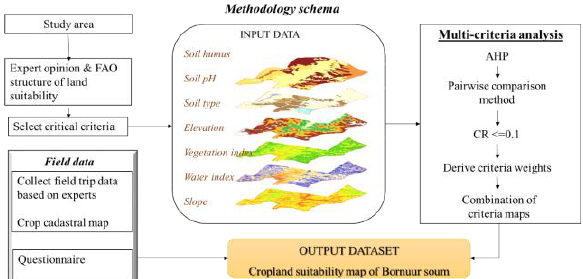
Figure 3. Flowchart methodology of the cropland